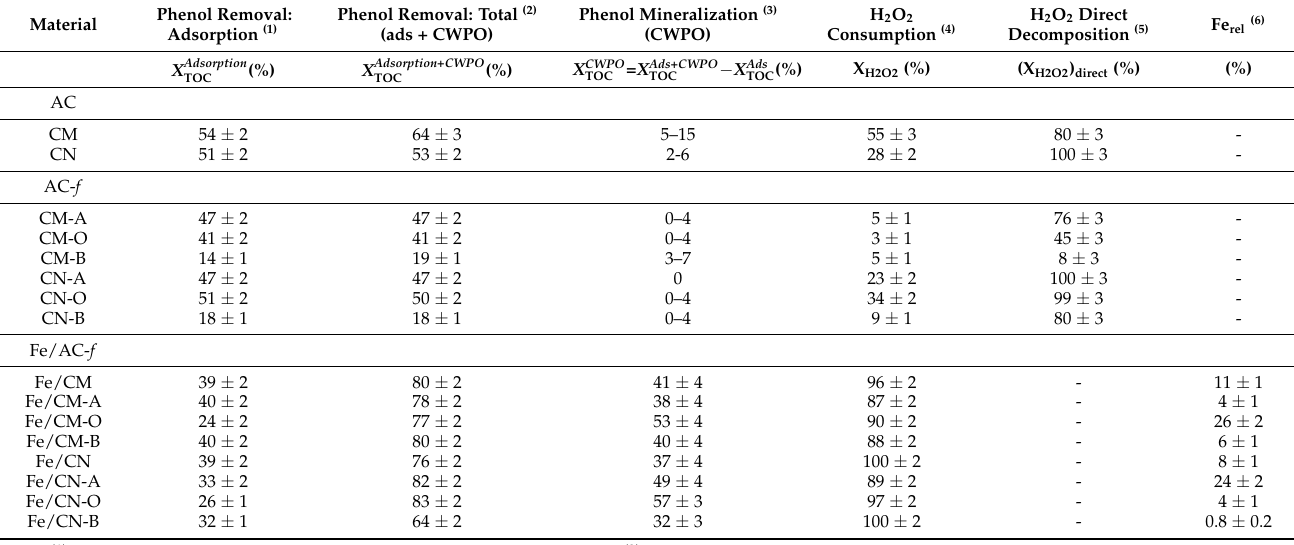
Table 6. TOC removal due to adsorption, CWPO and total contribution, H 2 O 2 consumption, H 2 O 2 direct decomposition, and iron release, for raw AC, AC- f supports and Fe/AC- f catalysts. Operating conditions: 50 mL reaction volume, 100 mg · L − 1